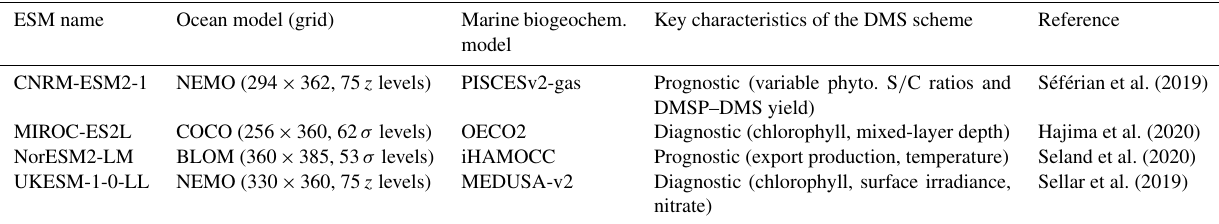
Table 1. Key characteristics of the ocean and marine biogeochemical components of the ESMs. Column 2: horizontal grid points (tripolar grids) and number of vertical levels. Column 4 in brackets: prognostic variables involved in the DMS parameterisations. Key characteristics of the DMS